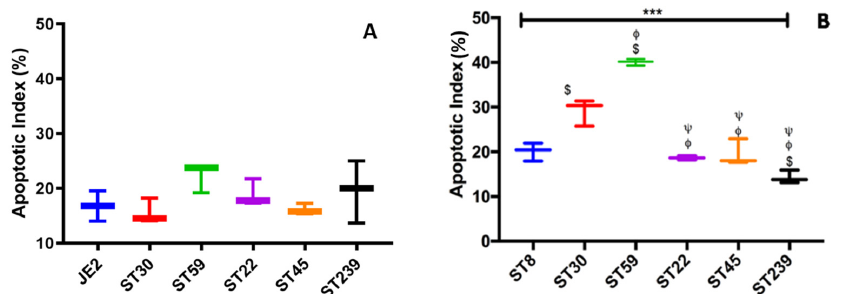
Figure 6. Quantification of the apoptotic index (%) ( A ) in HaCaT cells 2 and half hour post infection and ( B ) in the skin model 48 h post infection with six MRSA strains representative of the common ST types. Error bars represent SD of the mean; statistical significance was calculated using one-way ANOVA (*** p < 0.001) and Tukey post hoc test. The p values are coded with respect to each strain and are derived from the comparison between the means of the two respective strains. Statistical significance was obtained at p < 0.05 when the strain was compared to ST8 ($), ST30 ( ϕ ) and ST59 ( ψ ), respectively.